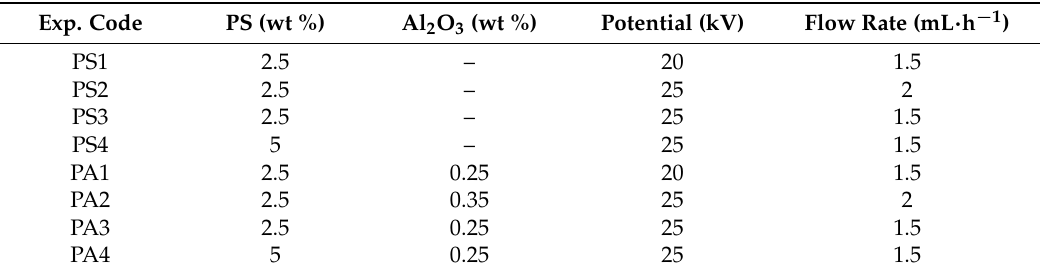
Table 1. Compositional ratios and electrospinning operational parameters for pure PS and PS/Al 2 O 3 nanocomposite